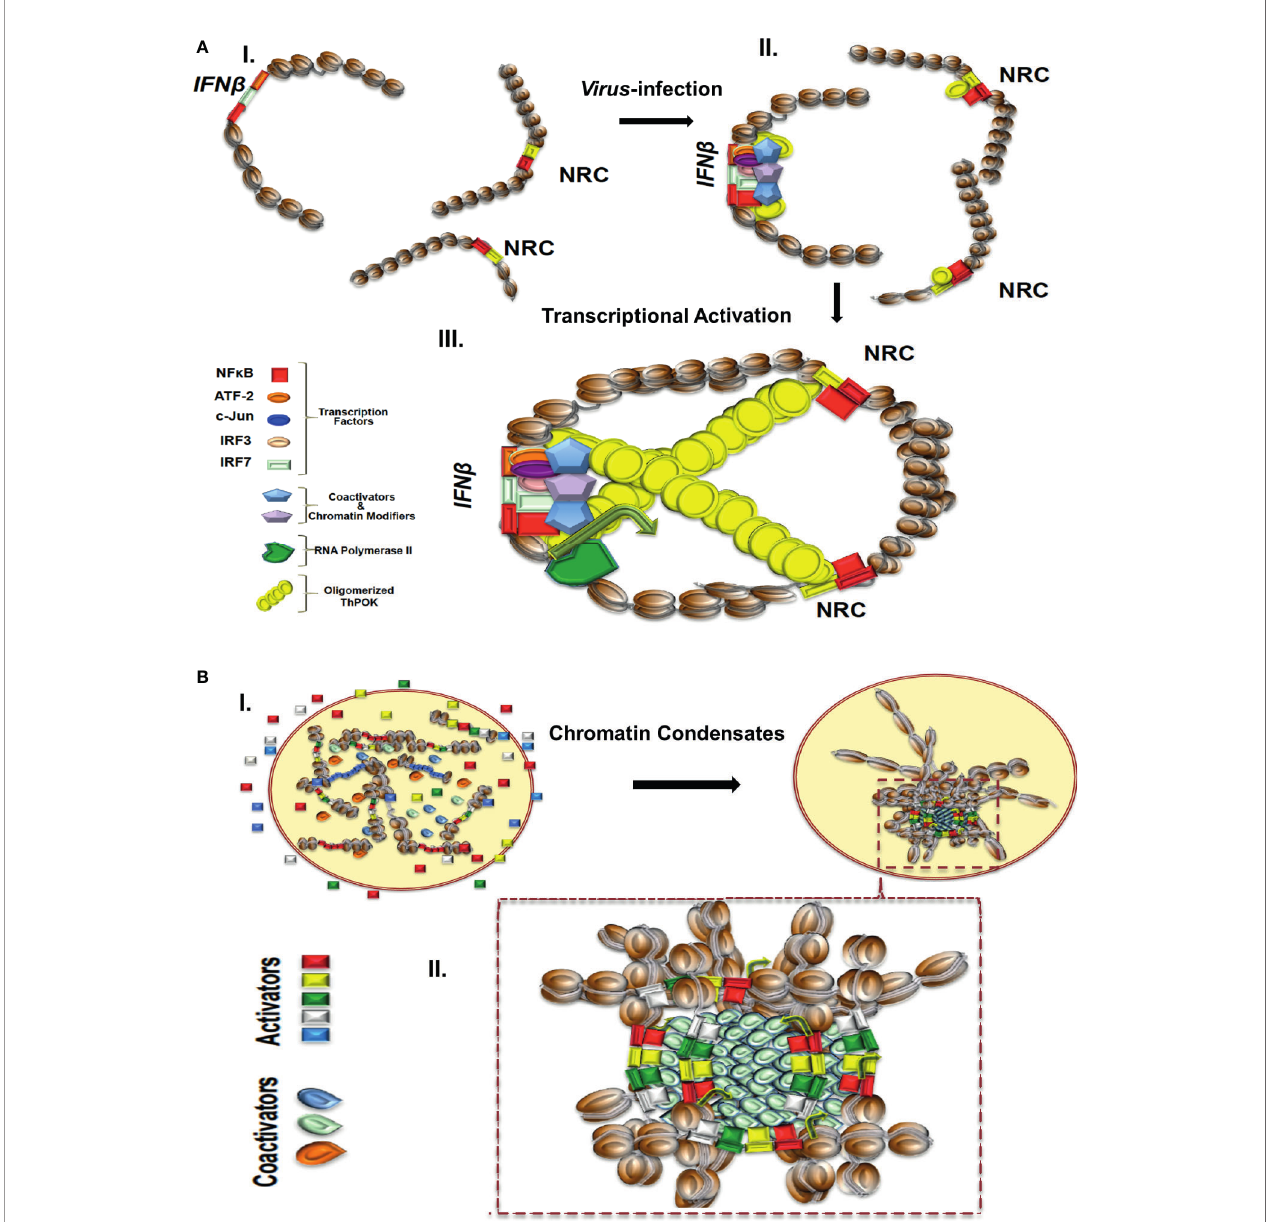
FIGURE 1 | (A) A model depicting the virus infection-induced NRC-IFN b interchromosomal interactions. In uninfected cells, the IFNB and NRC loci are well separated. Virus infection induces the nuclear localization of NF- k B, which binds cooperatively with ThPOK to appropriately spaced binding sites at NRCs (right part). While bound to NRCs, ThPOK oligomerizes to reach to a single IFN b allele resulting in physical proximity of the NRCs-bound NF- k B with the IFN b enhancer triggering enhanceosome assembly and subsequently activation of the IFN b gene. (B) A model depicting the assembly of enhancer hubs and transcriptional condensates. In resting cells enhancers and transcriptional regulators are diffused in the nucleus. Upon cell activation transcriptional condensates bearing enhancers, promoters and regulators are formed as a result of liquid-liquid phase separation. Components are highly concentrated within the